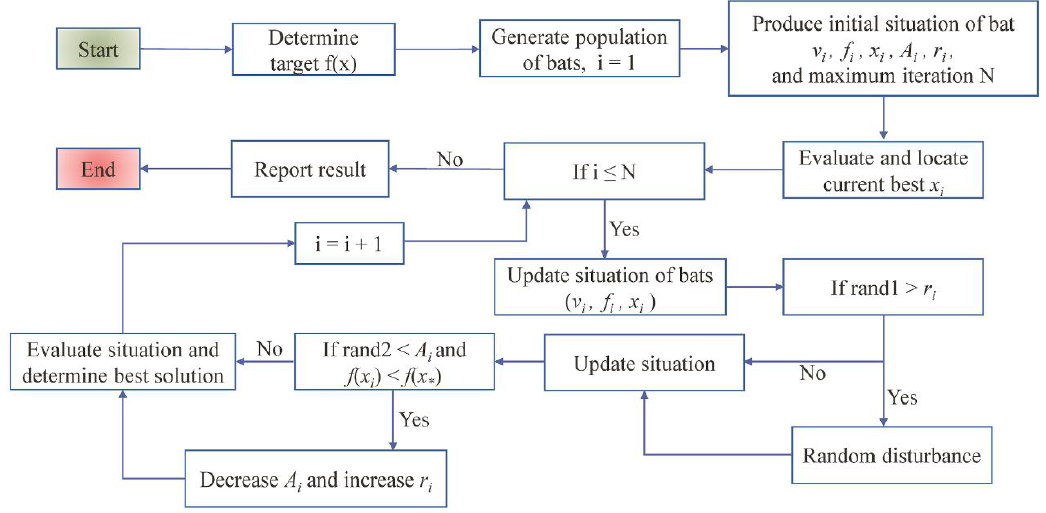
Figure 2. The flowchart of the Bat algorithm.